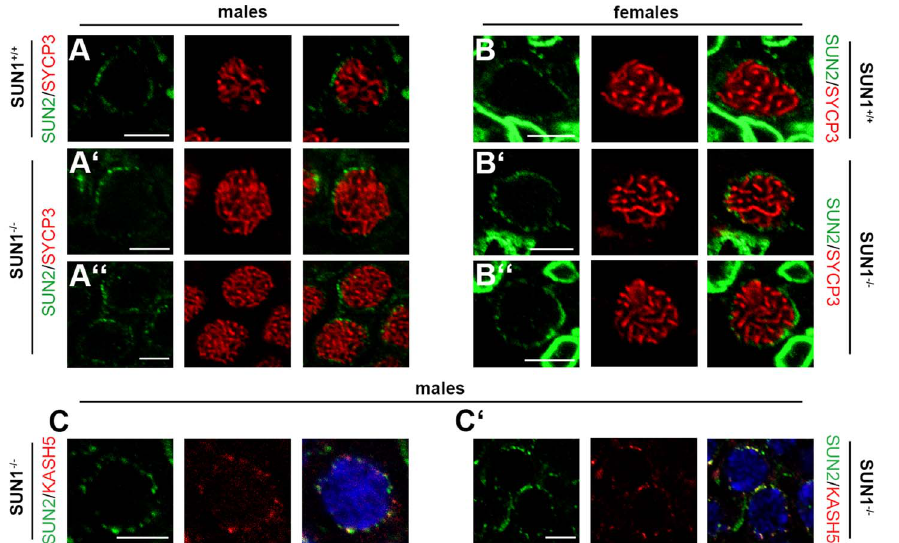
Figure 3. Meiotic telomere tethering by LINC complex components in the absence of SUN1. (A,B) Representative meiocytes in paraffin sections of testis and ovary tissue of Sun1 + / + ( D ex10-11) and Sun1 2 / 2 ( D ex10-11) mice labeled by anti-SUN2 and anti-SYCP3 antibodies. SUN2 foci, located at the end of synaptonemal complex axes, are present in both wildtype spermatocytes and oocytes (A, B). Similar SUN2 signals are also present in spermatocytes and oocytes ofSUN1deficientlittermatemice(A 9 ,A 0 ,B 9 ,B 0 ).Thenuclear envelopeofsomaticcellsintheovarytissueofboth Sun1 + / + ( D ex10-11) and Sun1 2 / 2 ( D ex10-11) females (B–B 0 ) is also strongly labeled by SUN2. (C–C 9 ) Spermatocytes in paraffin sections of testis tissue of Sun1 2 / 2 ( D ex10-11) males labeled by anti-SUN2 and anti-KASH5 antibodies. In SUN1 deficient spermatocytes KASH5 and SUN2 co-localize, both showing distinct foci at the nuclear periphery. DNA counterstained using Hoechst 33258. Scale bars 5 m m.